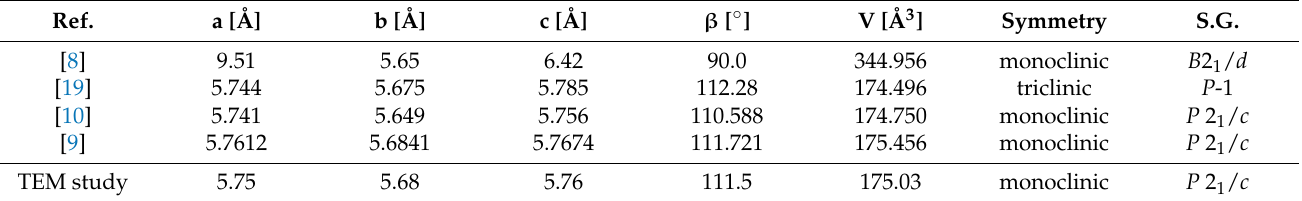
Table 2. Reference values and experimentally measured unit cell parameters for arsenopyrite.